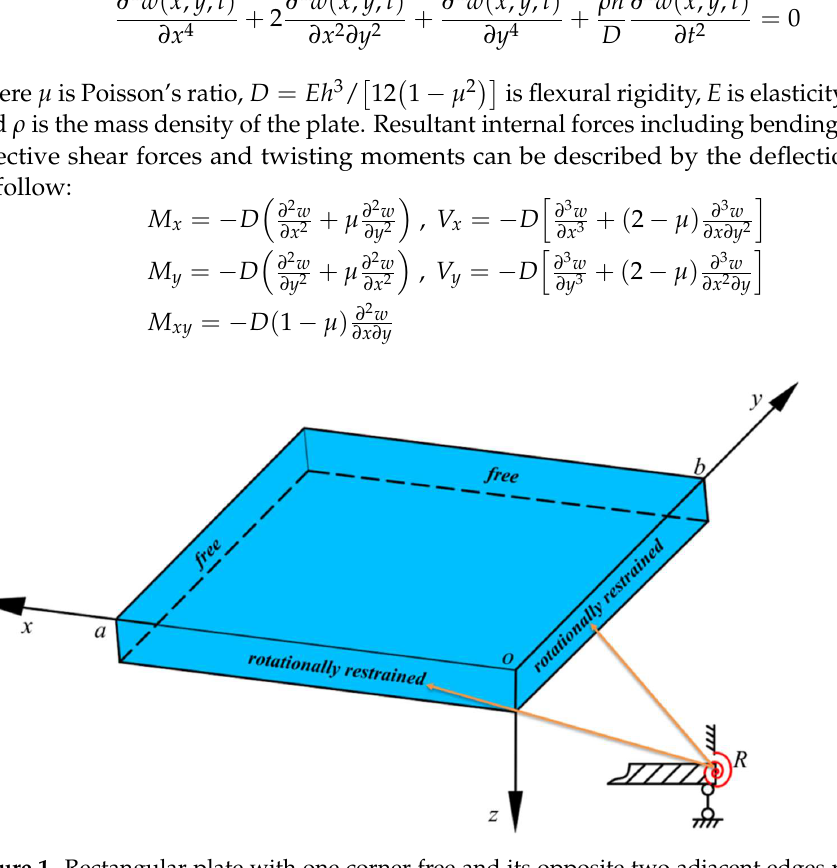
Figure 1. Rectangular plate with one corner free and its opposite two adjacent edges rotationally restrained.